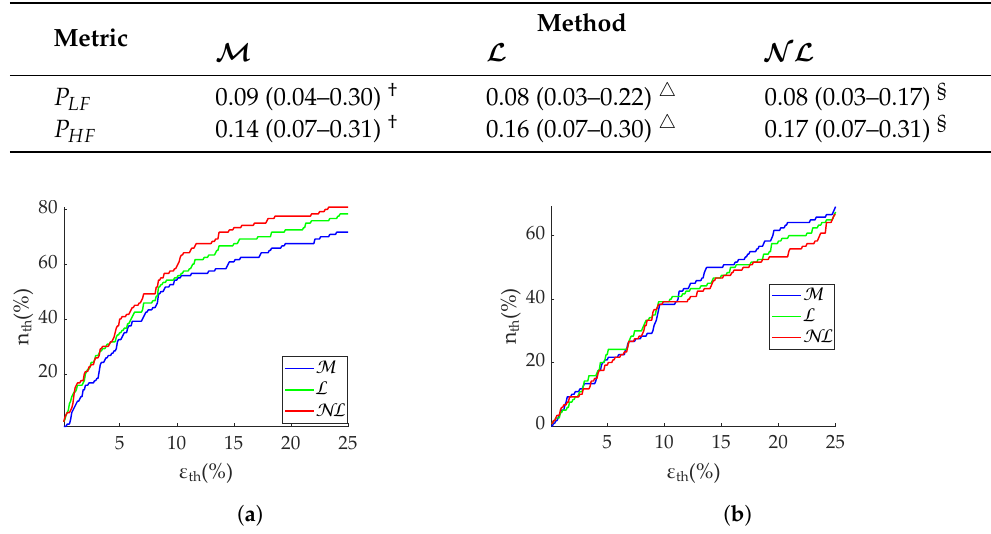
Figure 6. Coverage of frequency-domain metrics computed via FFT from Apple Watch dataset.